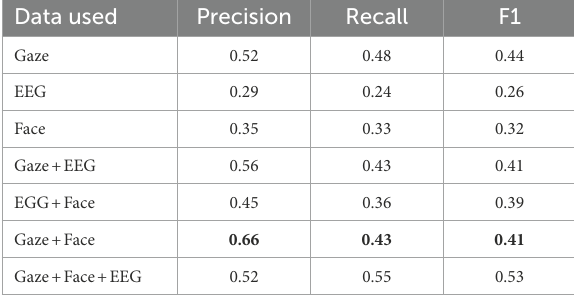
Bold values represent best performance. TABLE 5 Learning outcomes prediction results. Data used